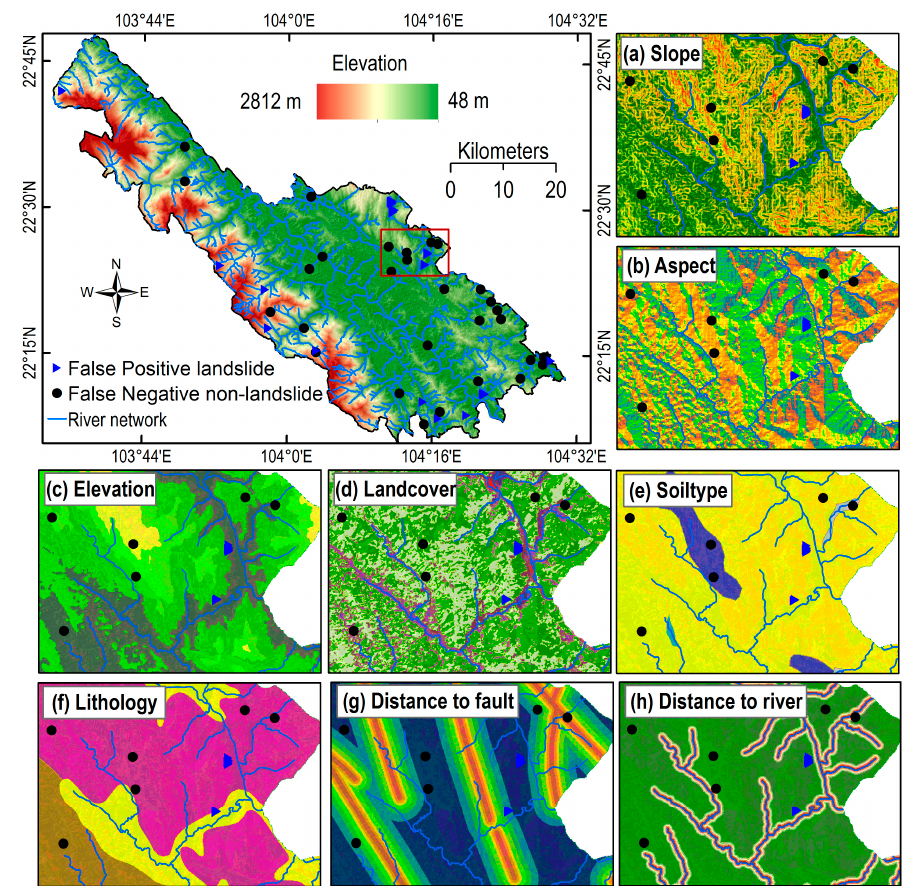
Figure 9 . Mispredicted landslide pixels (false positive) and mispredicted non-landslide pixels in the validation dataset versus the eight landslide predisposing factors (legend for the eight factors was the same as in Figure 4). ( a ) Slope; ( b ) Aspect; ( c ) Elevation; ( d ) Landcover; ( e ) Soil type; ( f ) Lithology; ( g ) Distance to fault; and ( h ) Distance to river.